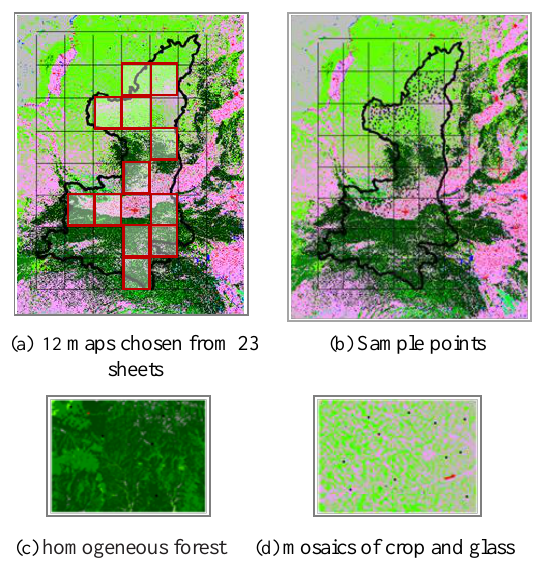
Figure 5. The results of